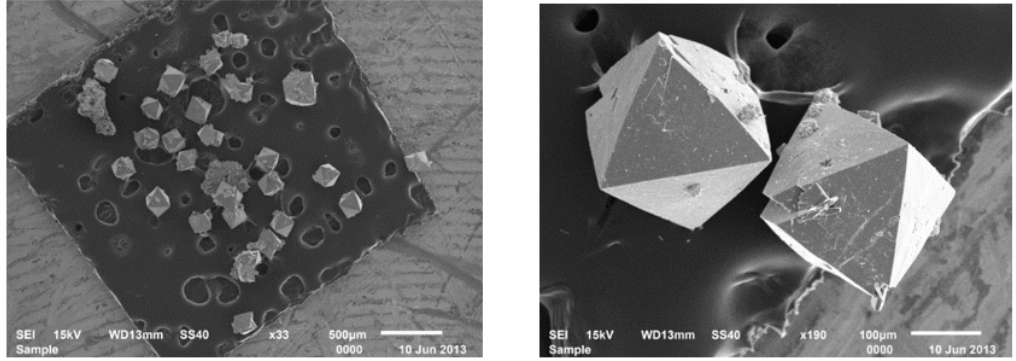
Figure 3. The SEM micrograph of catalyst 1 .